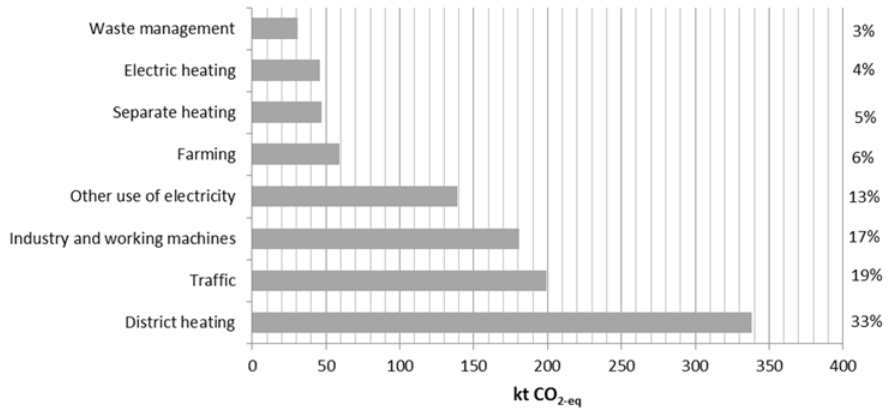
Figure 1. Amount of CO 2 emissions (kilotonnes CO 2-eq ) by emission sector in the Kuopio area in 2010.